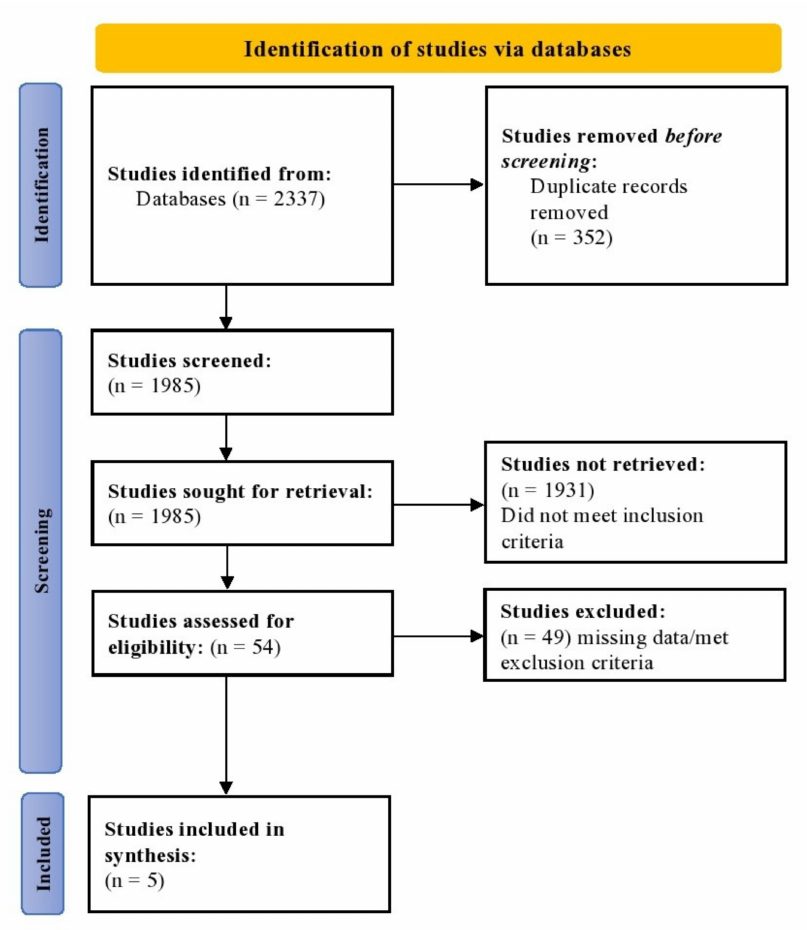
Figure 1. PRISMA flowchart depicting the study selection process. The figure enlists the number of studies identified, the screening process of the studies, and the inclusion